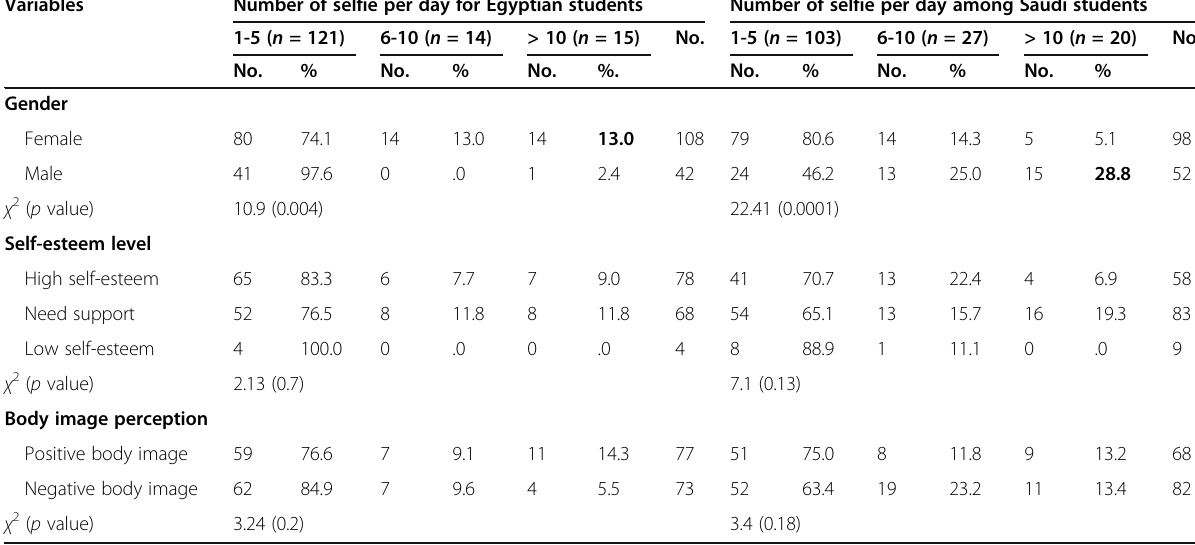
Table 6 Relationship between the number of selfies Egyptian and Saudi students per days and their gender, self-esteem, and body image perception